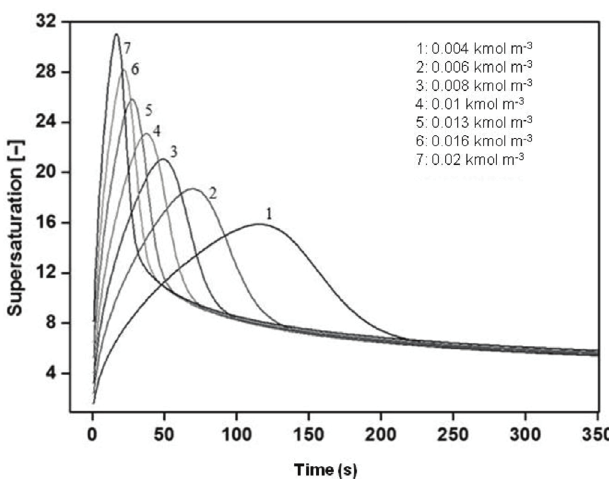
Fig. 2 – Local supersaturation distribution during process of semi-batch reactive crystallization of calcium oxalate at 5 mL min –1